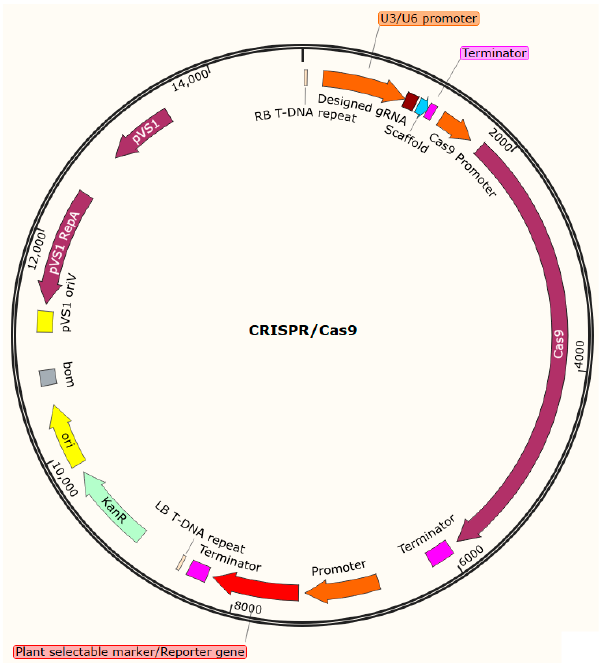
Figure 1. The schematic representation of a binary vector harboring gRNA, Cas9, and selectable marker/reporter gene cassettes in its T-DNA region for targeted genome editing of